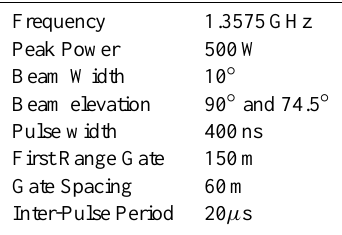
Table 1. Parameters of the wind profiler.